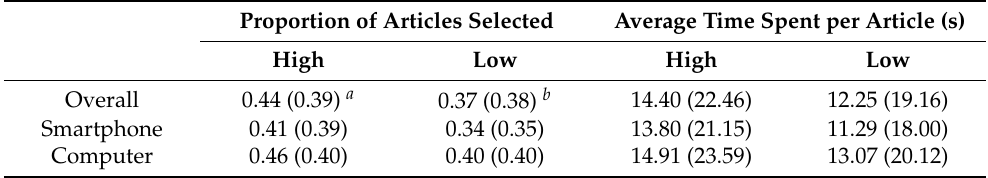
Table 2. Impact of on Social Cues by Browsing Device Condition (Study 1). Proportion of Articles